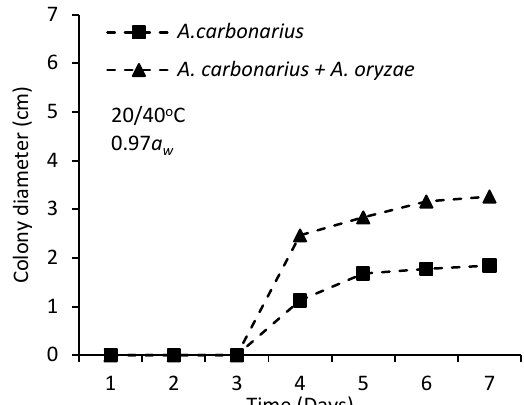
Figure 6. Growth of A. carbonarius inoculated in single and dual cultures with A. oryzae incubated under fluctuating temperatures of 20/40 °C with 15 h/9 h cycling time at 0.97 a w for 7 days on chili-based agar.